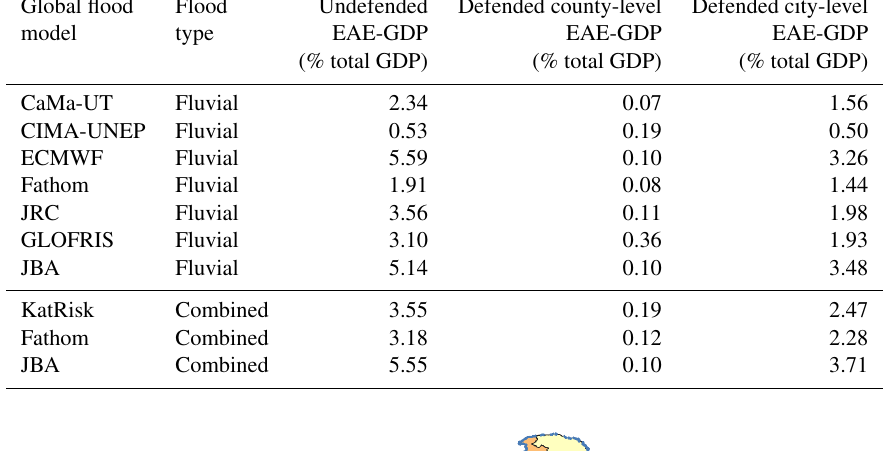
Table 4. EAE-GDP results of the eight GFMs for the undefended, county-level defended, and city-level defended exposed-GDP scenarios. The values are expressed as EAE-GDP percentages of China.